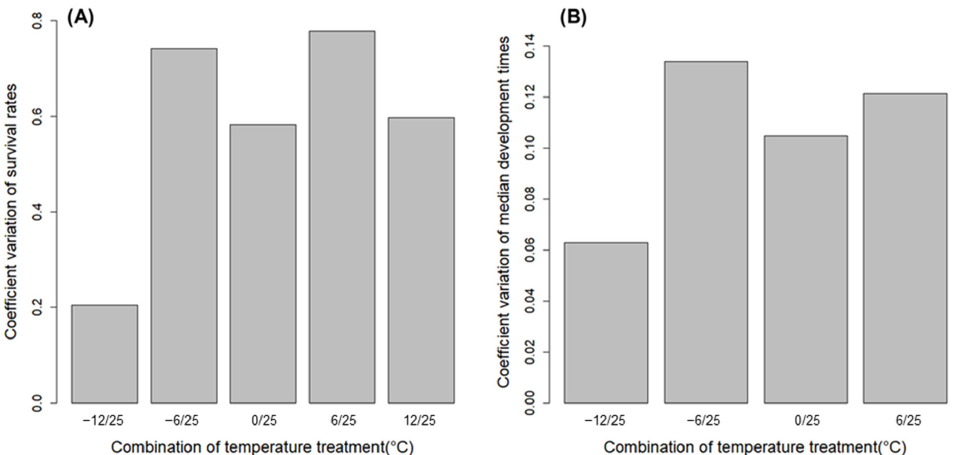
Figure 4. Coefficient variation (CV) of ( A ) survival rate and ( B ) median development time of Lymantria dispar asiatica eggs of sampled sites ( n = 8) for each treatment. The development completion models clearly show the effect of chilling temperatures